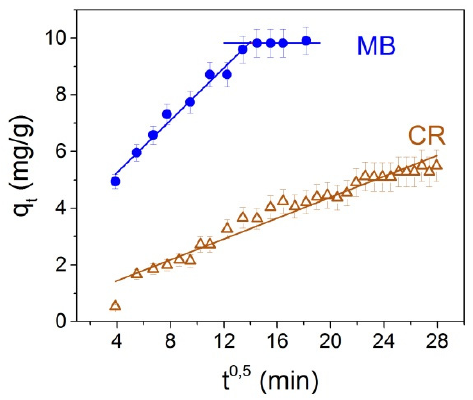
Figure 12. The q t dependencies t 1/2 calculated with Equation (5) for MB (circles) and CR (triangles). To obtain the relationship between the quantity of gas adsorbed into a solid surface and the gas pressure, H. Freundlich proposed in 1909 an empirical expression describing the isothermal variation of a quantity of gas adsorbed by unite mass of solid adsorbent in dependence on gas pressure known now as the Freundlich isotherm [38]. The same equation began to be used to describe the concentration of a solute adsorbed onto the surface of a solid